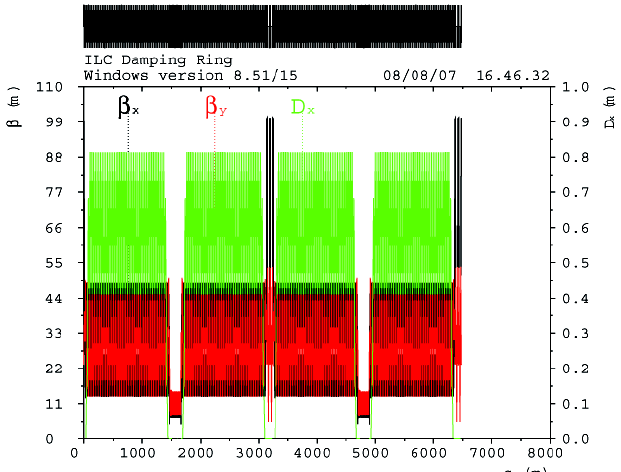
FIG. 7. (Color) Twiss parameters for the whole ring, with mo- mentum compaction factor 4 (cid:1) 10 (cid:2) 4 .